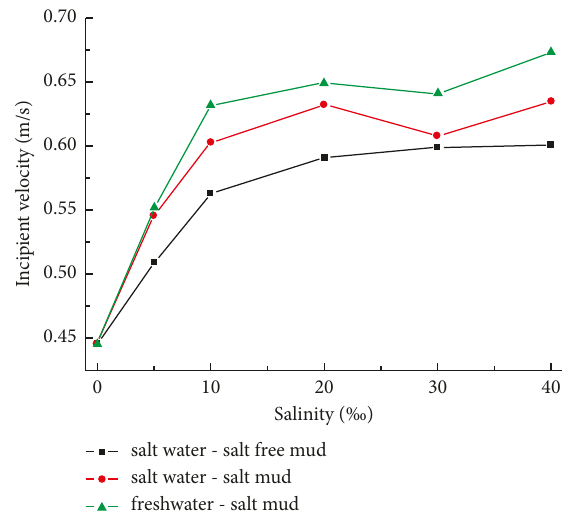
Figure 5: The variation of incipient velocity with